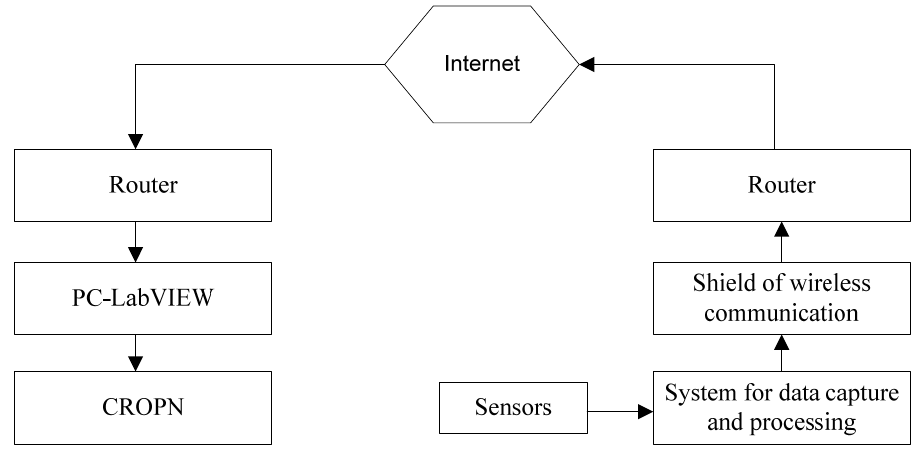
Figure 1. Flowchart of the resource failure sensing.